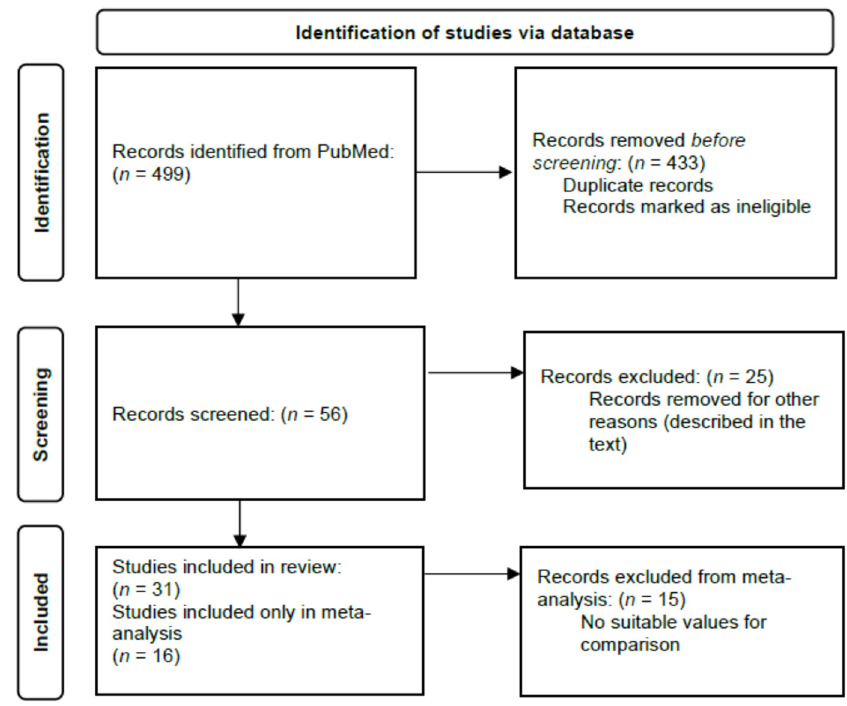
Figure 1. PRISMA flow diagram of the study selection process for all of the articles. The selected articles had to relate to one of six supplements, such as: resveratrol, pyc- nogenol, beetroot juice, barberry, bergamot, or cherry juice.